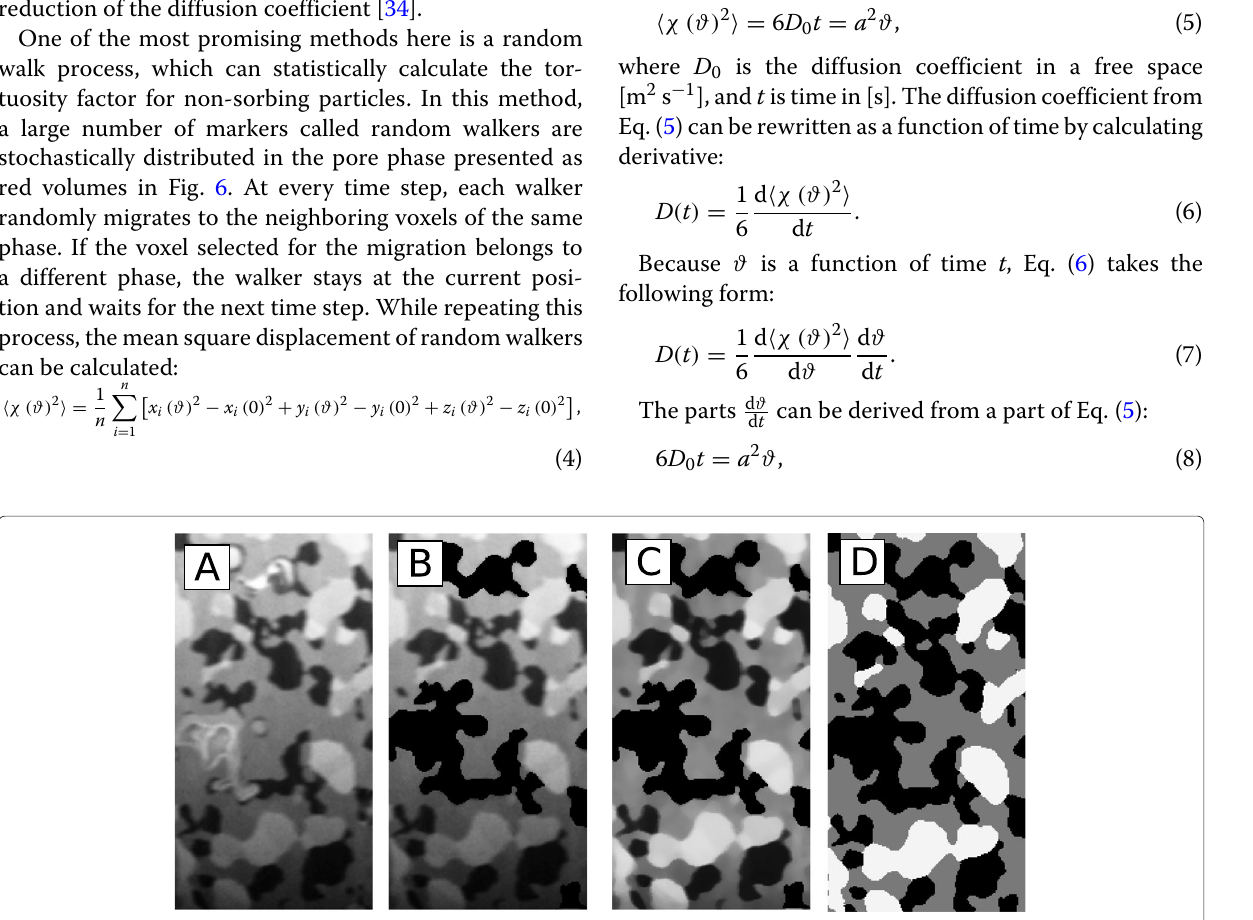
Fig. 5 The workflow of the image processing and phase labeling. a A raw image. b Manually removed experimental artifacts. c Filtering. d Phase labeling where white represents nickel, black is pores, and gray denotes